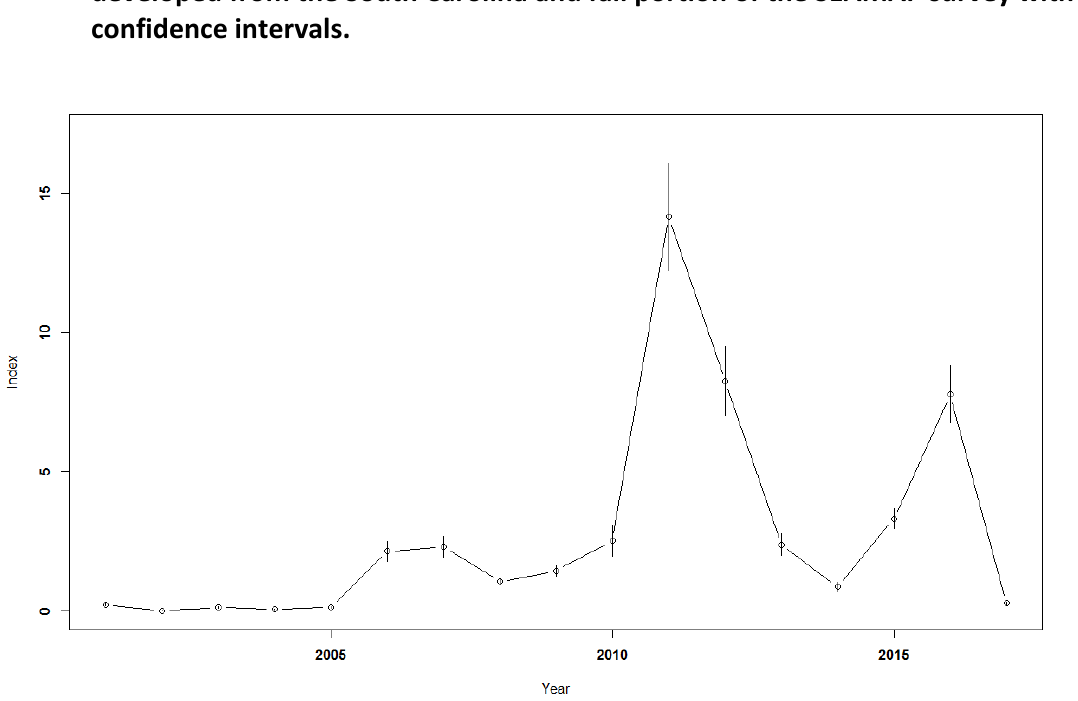
Figure 70. Index of relative abundance of horseshoe crab (delta mean catch per tow) developed from the Georgia-Florida and fall portion of the SEAMAP survey with 95% confidence